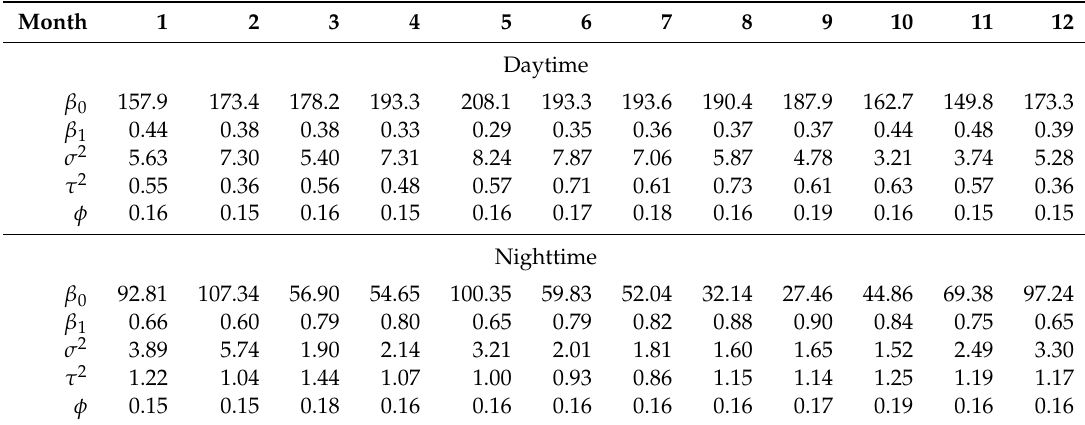
Table 4. Parameter medians of the daytime and nighttime models for each month in